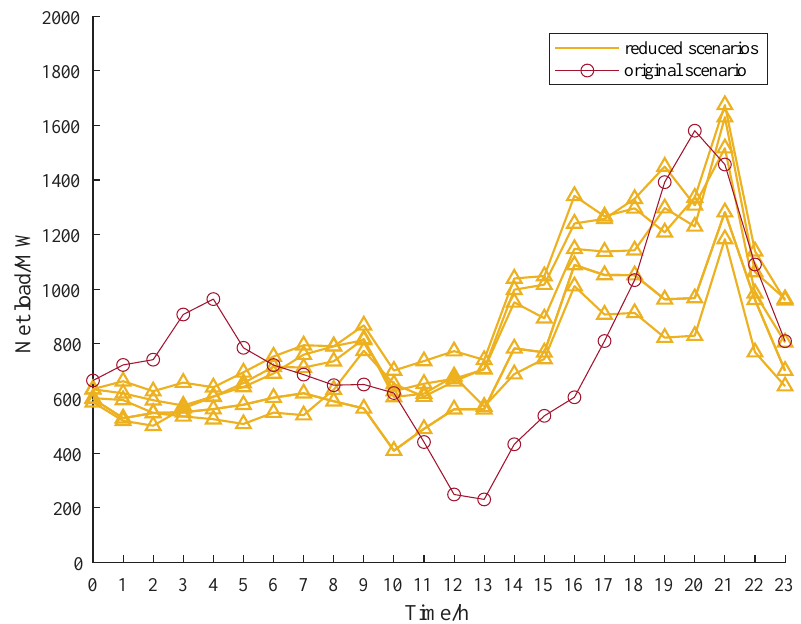
Figure 9. Results of Copula function generation scenario method .